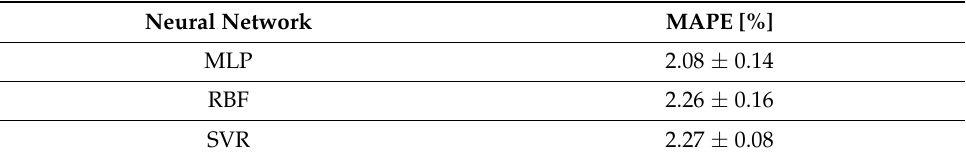
Table 1. The statistical results of prediction of 24-h load pattern at an expert selection of input attributes (number of applied hidden neurons in MLP was 35, in RBF 70, σ = 0.9, ε = 0.01, and C = 1000 in SVR). They correspond to the testing data. The values of MAPE and standard deviation correspond to the mean of 10 repetitions of experiments. Irrespective of the applied neural predictors, their values are not very far from each other.